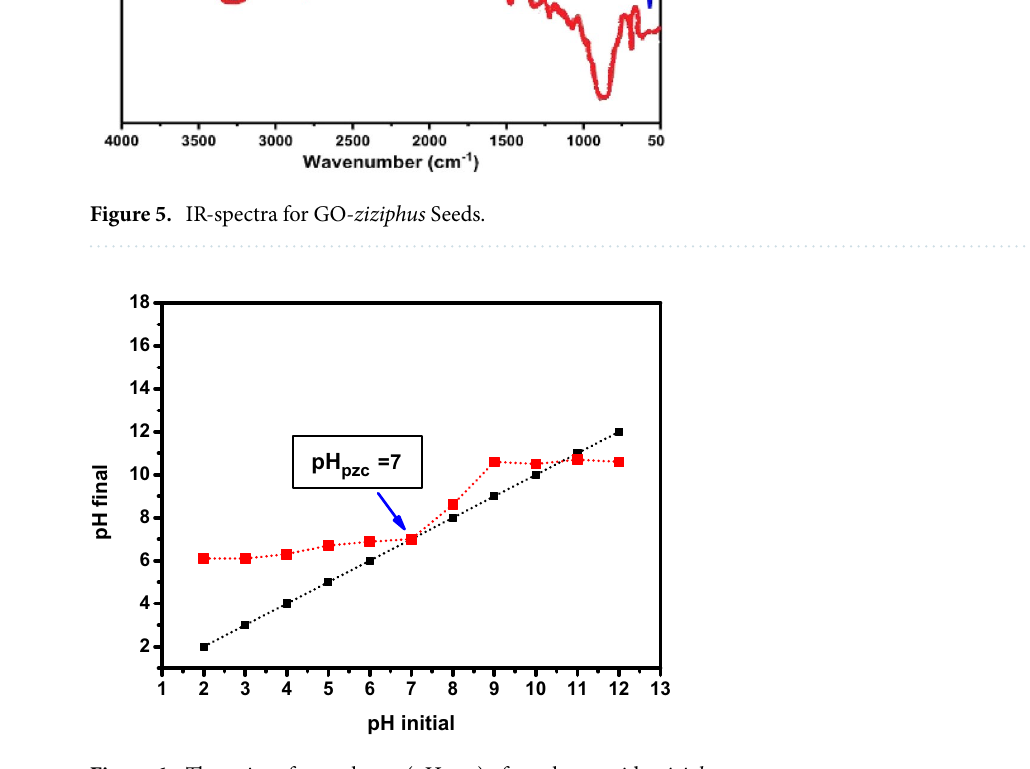
Figure 6. The point of zero charge (pH pzc) of graphene oxide- ziziphus